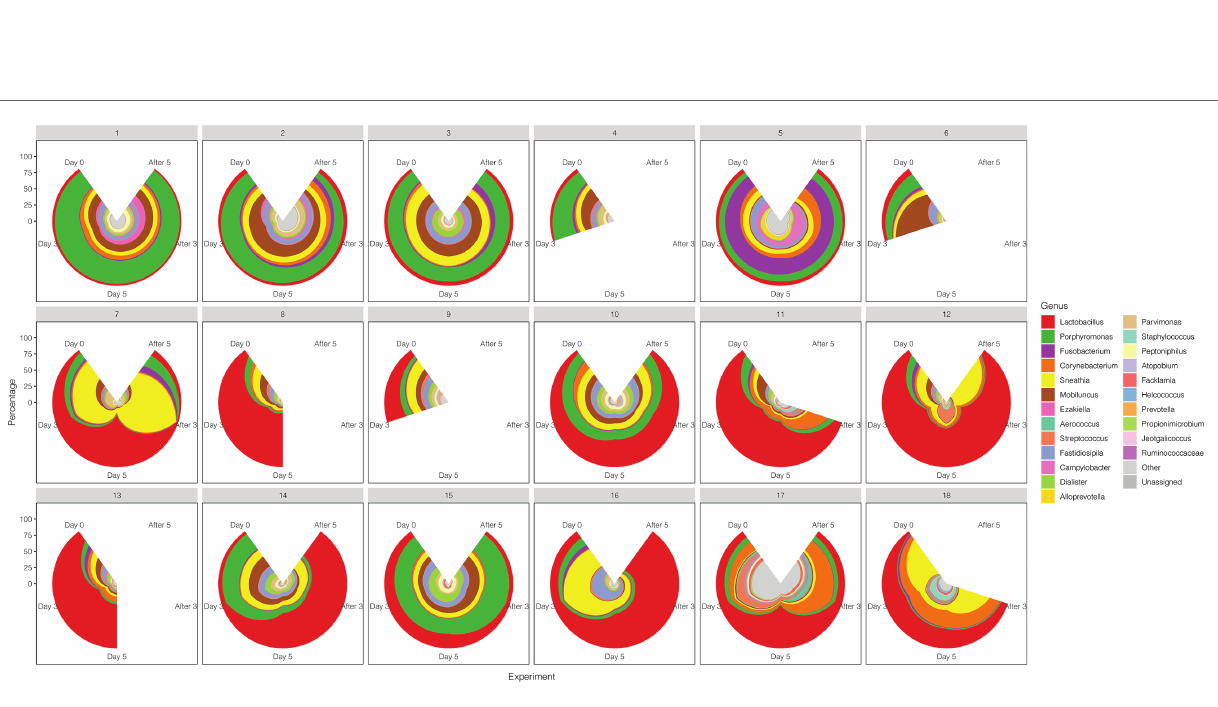
FIGURE 2 | The diversity of the vaginal microbiota during the follow-up of each sample in control and test groups. The radius represents the percentage of the